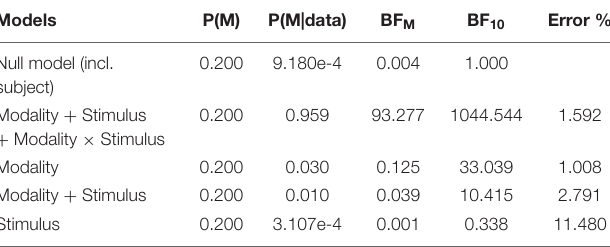
TABLE 1 | Bayes factors of Bayesian repeated measures ANOVA in the unimodal session.